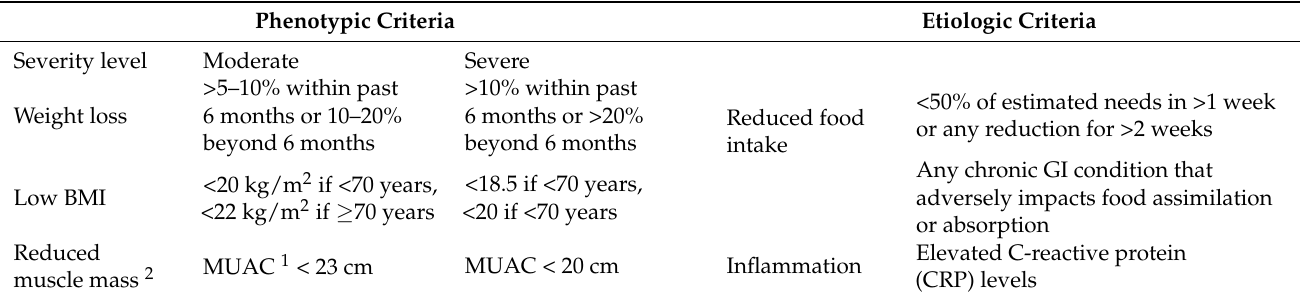
Table 1. GLIM criteria for diagnosis of malnutrition